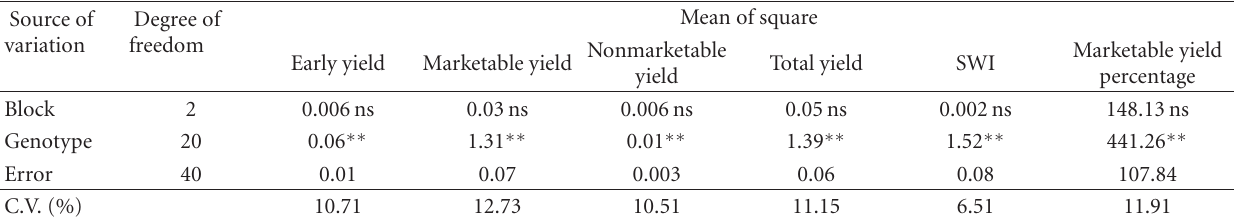
Table 1: ANOVA table e ff ect of genotype on yield and some yield components.